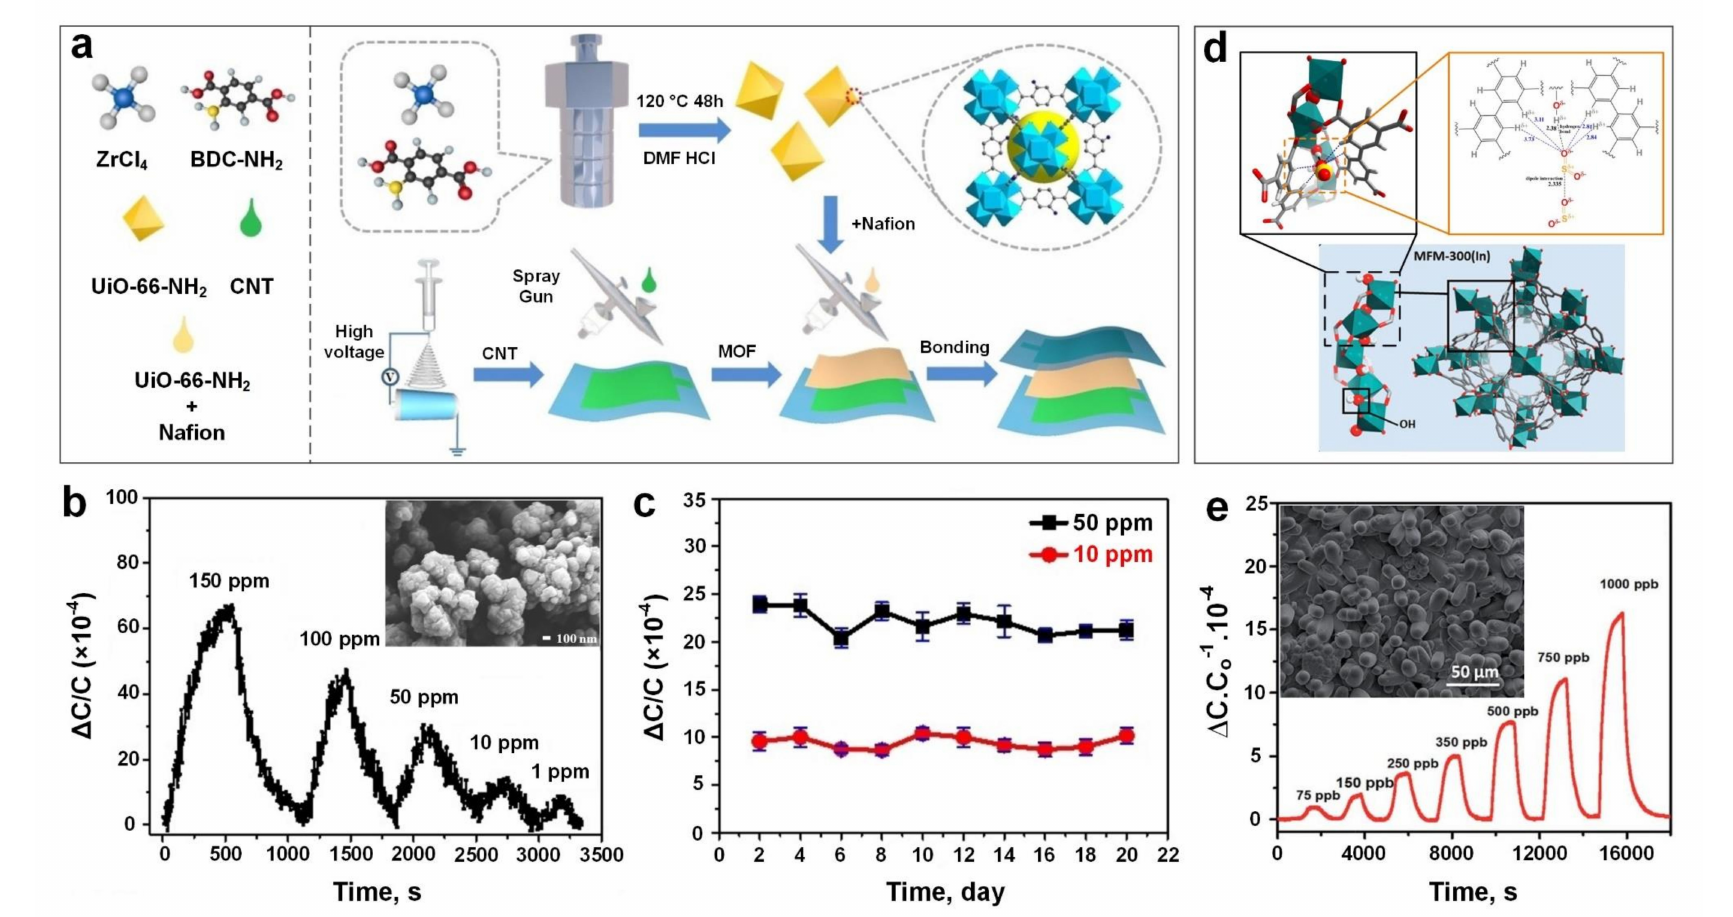
Figure 7. ( a ) Schematic illustrations of UiO-66-NH 2 preparation on flexible PVDF layer for capacitive SO 2 gas sensor. ( b ) The dynamic capacitance variations of UiO-66-NH 2 versus different SO 2 gas concentrations, and the SEM image of UiO-66-NH 2 powder (Inset). ( c ) The stability tests of UiO-66-NH 2 based gas sensor under 10 and 50 ppm of SO 2 gas for over 20 days. Reproduced with permission from [28] Wiley-VCH, 2021. ( d ) The structure of MFM-300 (In) MOF and the sites for SO 2 adsorption. ( e ) The capacitive response of MFM-300 (In) MOF against varied SO 2 gas concentrations, and the SEM image of MFM-300 (In) MOF thin film as inset. Reproduced with permission from [100] The Royal Society of Chemistry,